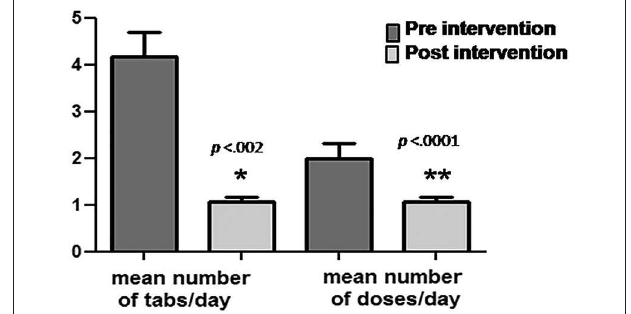
FIGURE 1 | Simplification of therapy by applying the drug protocols available for adult patients. Both the mean number of daily pills and number of daily drug doses were significantly reduced (4.18 ± 1.72 to 2.0 ± 1.1, p < 0.002, and 1.82 ± 0.4 to 1.09 ± 0.3, p < 0.0001, respectively) during the transition period. * p < 0.005; ** p <